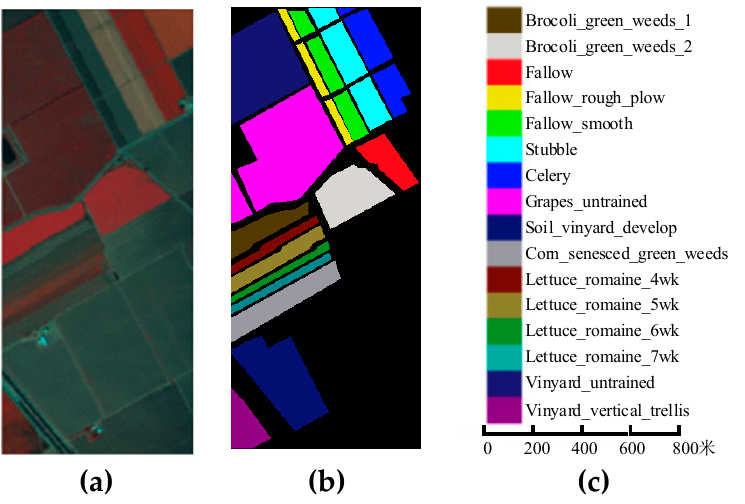
Figure 4. The Salinas dataset. ( a ) False-color composite image; ( b ) ground truth map; ( c ) scale bar. For the Pavia dataset, it was obtained by the Reflective Optics Spectrographic Imaging System (ROSIS) sensor over an urban scene by Pavia University, Italy, in 2001. This dataset has a size of 610 × 340 pixels with 1.3 m spatial resolution, and the spectral ranges from 0.43 to 0.86 µ m. Due to the SNR and water absorption, 12 bands were removed, and the remaining 103 bands were used in the experiments. There are nine urban classes to discriminate. Figure 5 shows the false-color composite image, the available ground-truth map, and the scale